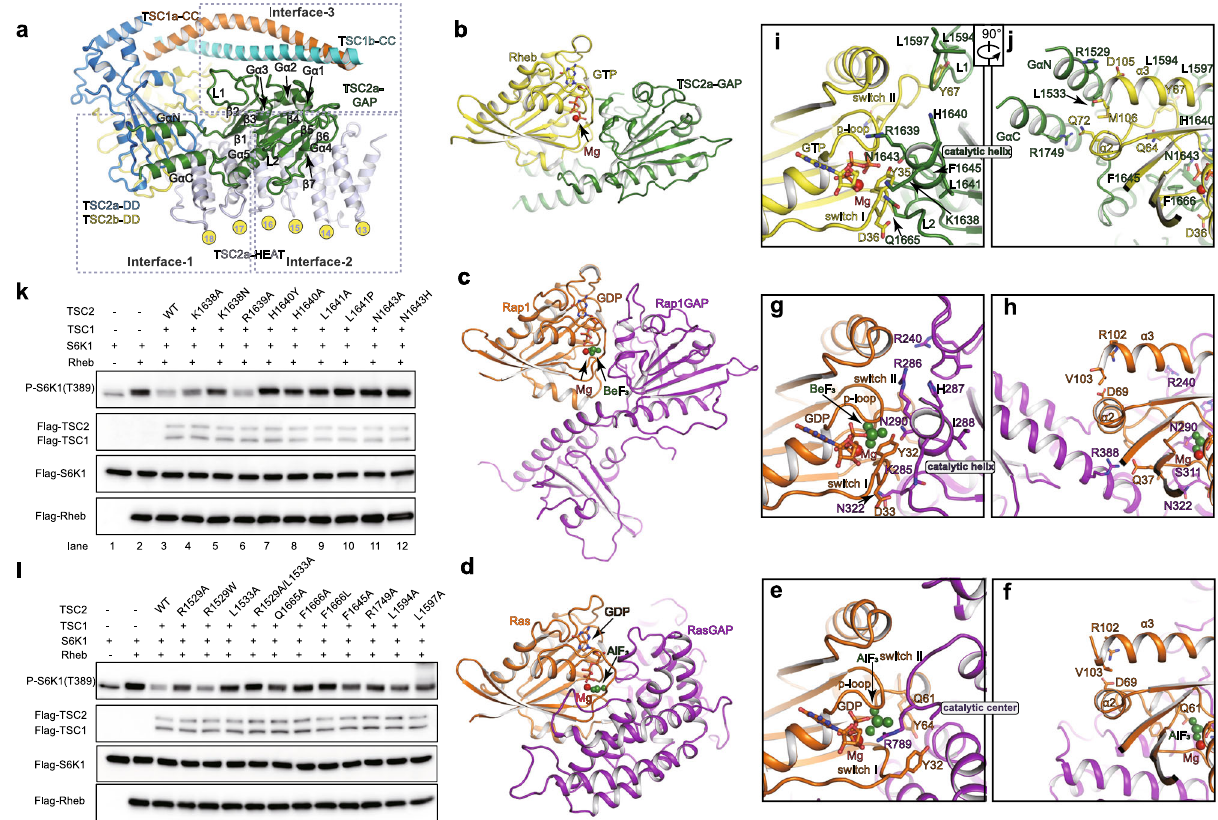
Fig. 3 TSC2 GAP catalytic mechanism and putative GAP – Rheb binding. a Close-up view of TSC2a GAP domain and its positioning. Three inter-domain contacts are highlighted with dashed boxes. Structural comparison of Rheb – TSC2 GAP ( b ), Rap1 – Rap1GAP (PDB:3BRW) ( c ), and Ras – RasGAP (PDB:1WQ1) ( d ). The structures are shown in a similar view. TSC2 GAP and Rheb are shown in green and yellow, respectively. Rap1 and Ras are colored in orange and Rap1GAP and RasGAP are colored in magenta, respectively. In ( b ), the GTP-bound Rheb (PDB:1XTS) and TSC2 GAP domain were, respectively, superimposed to Rap1 and Rap1GAP in Rap1 – Rap1GAP structure. Two different close-up views of the catalytic centers of RasGAP ( e , f ), Rap1GAP ( g , h ), and TSC2 ( i , j ). The structures are derived from ( b – d ). Magnesium cations are shown as red balls. The beryllium tri fl uoride (BeF 3 ) and aluminum tri fl uoride (AlF 3 ) are shown as green balls. The GDP – BeF 3 and GDP – AlF 3 are the mimetic ATP in ground and transition states, respectively. Residues involved in binding and catalysis are shown in sticks. k , l Cell-base GAP activity assays of wild-type TSC2 and TSC2 mutants. The HEK293A cells were transfected with ( + ) or without ( − ) the indicated plasmids in the upper of the panel. The activities were detected by western blotting with antibody against phosphorylated-S6K (T389). The effects of residues involved in catalysis ( k ) and Rheb binding ( l ) were tested. Source data are provided as a Source Data fi le for uncropped